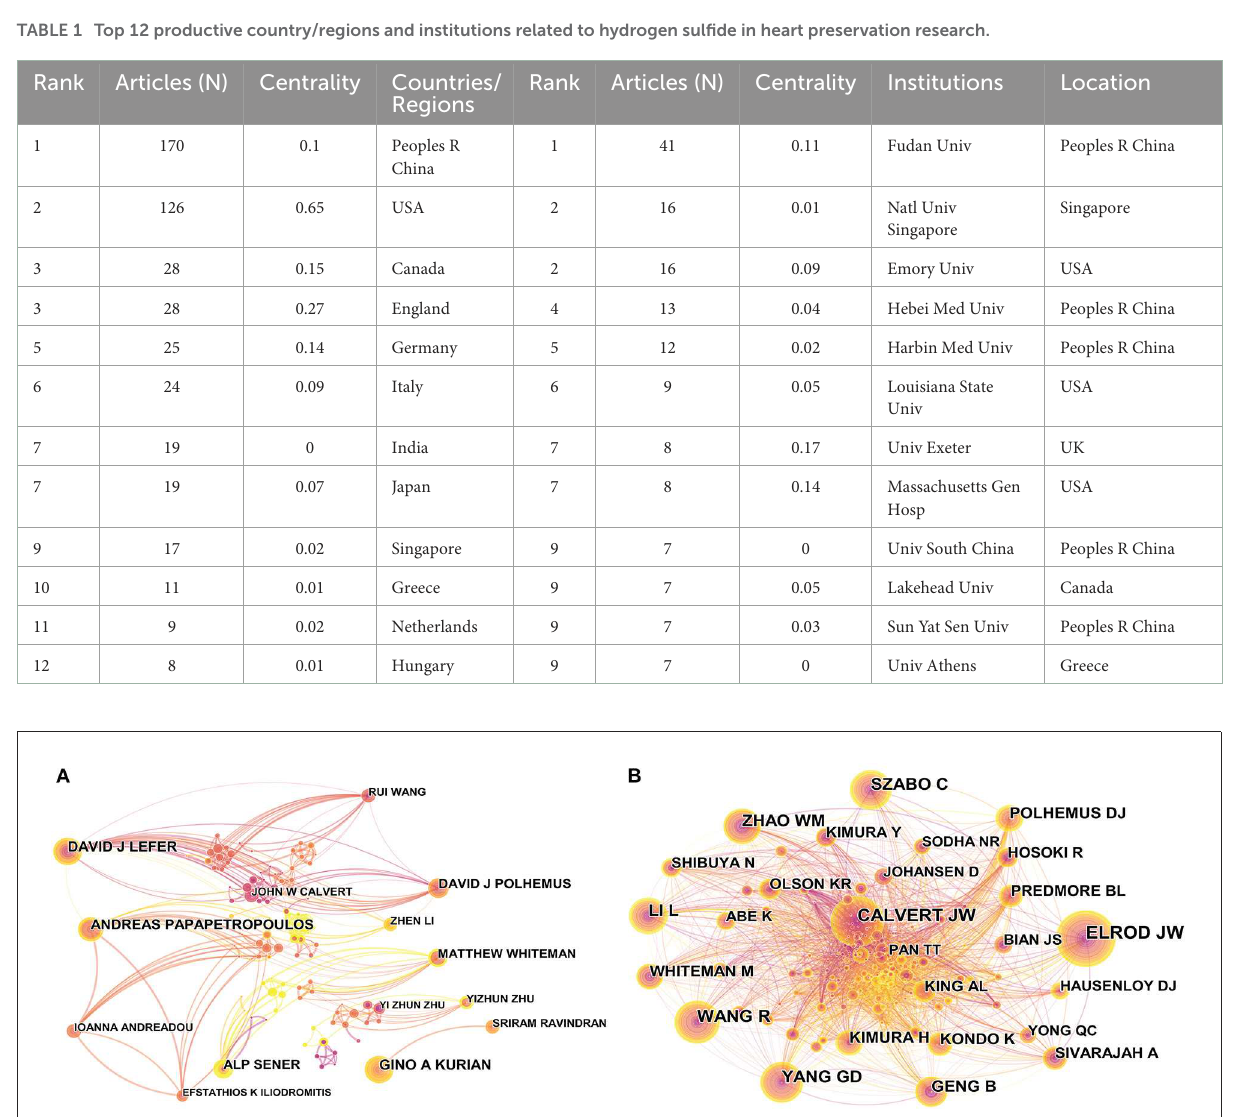
FIGURE3 CiteSpace network visualization map of authors and co-cited authors of the articles related to hydrogen sulfide in heart preservation research. (A) CiteSpace network visualization map of authors. (B) CiteSpace network visualization map of co-cited